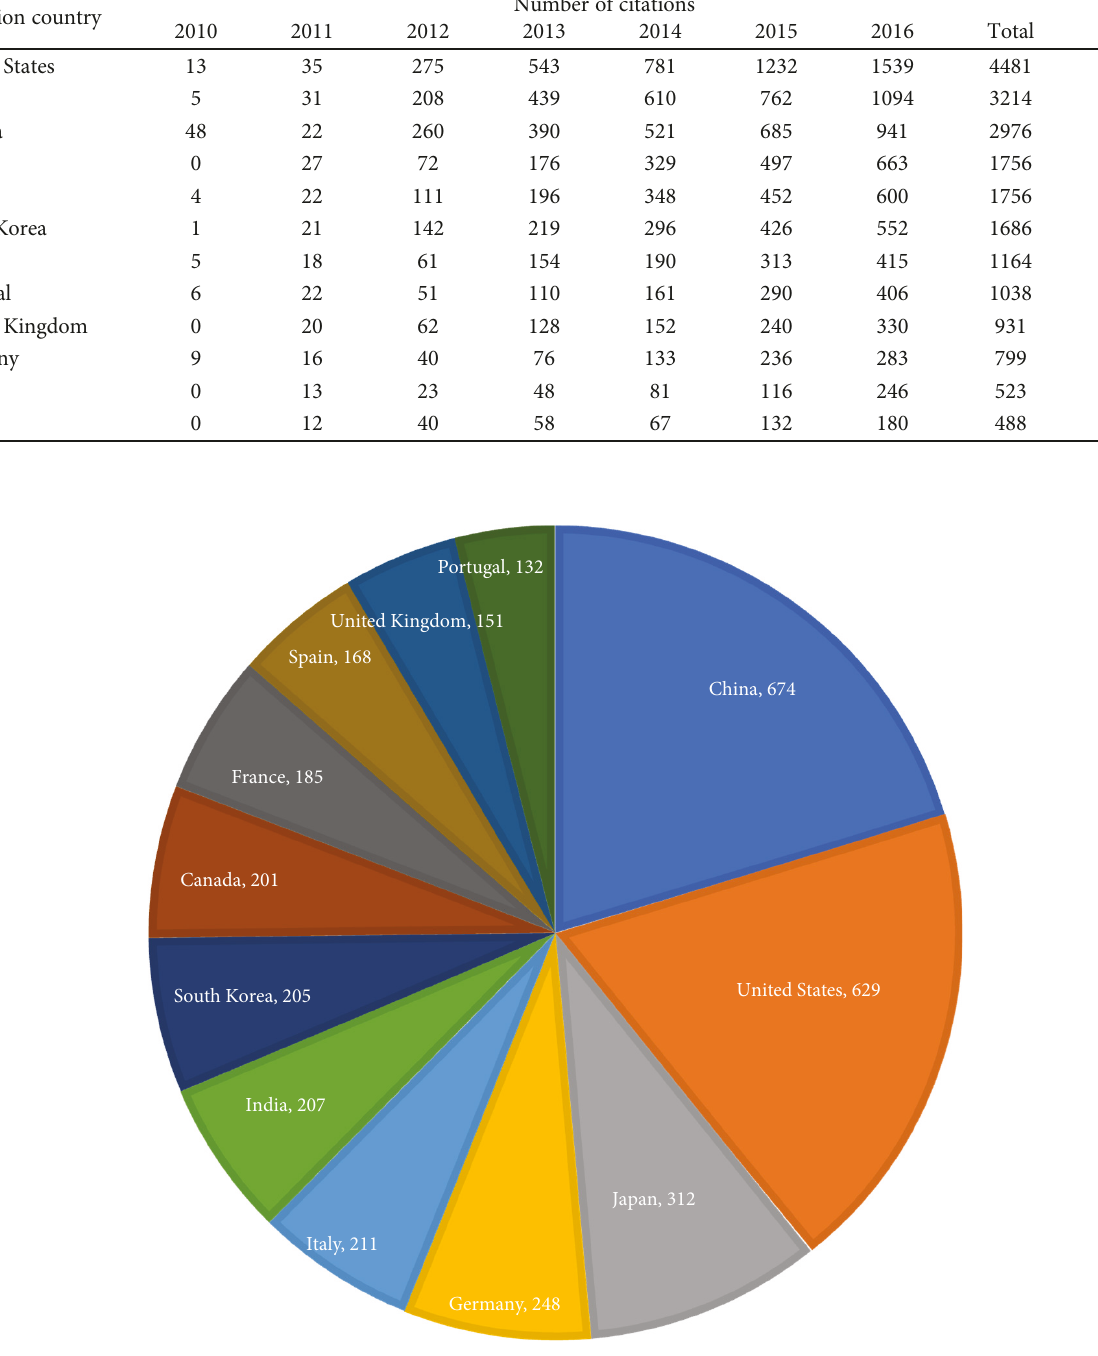
Figure 9: Documents produced between 2010 and 2016 by a ffi liation country (top 12) for search term ( “ energy resource management ” OR “ energy management system ” ) in the SCOPUS